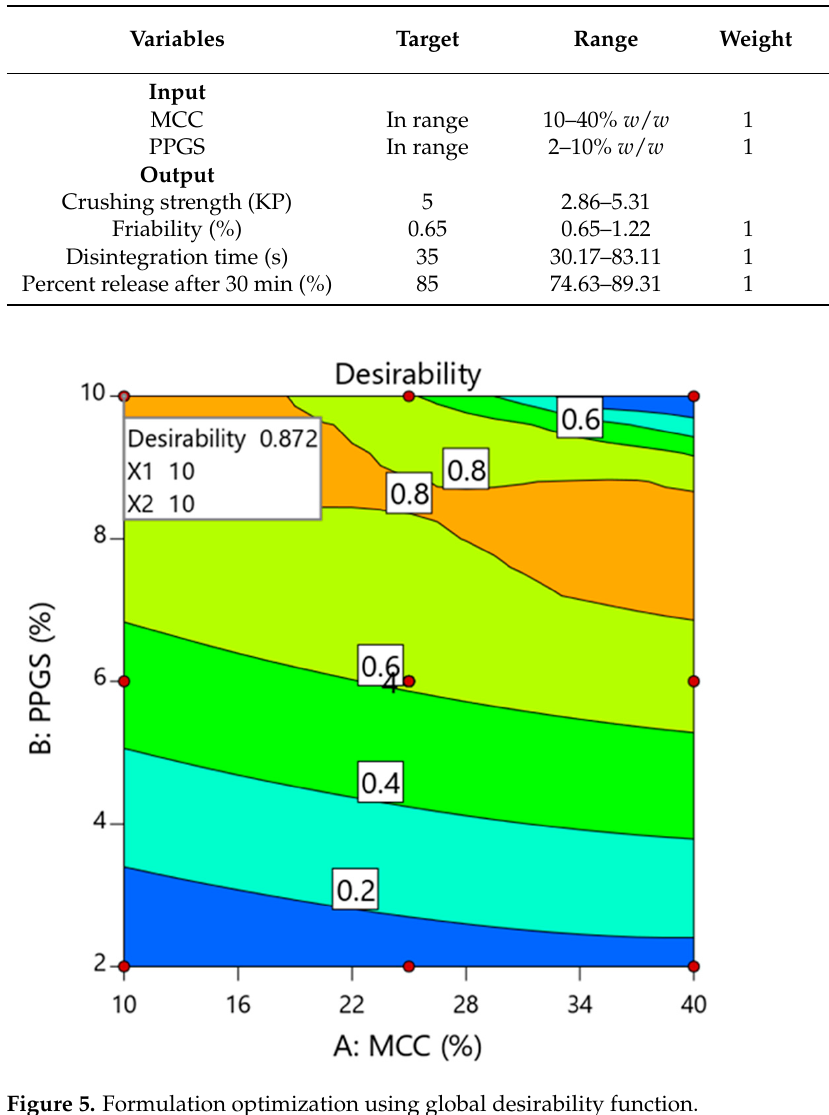
Table 10. The constraints adopted for developed design space.